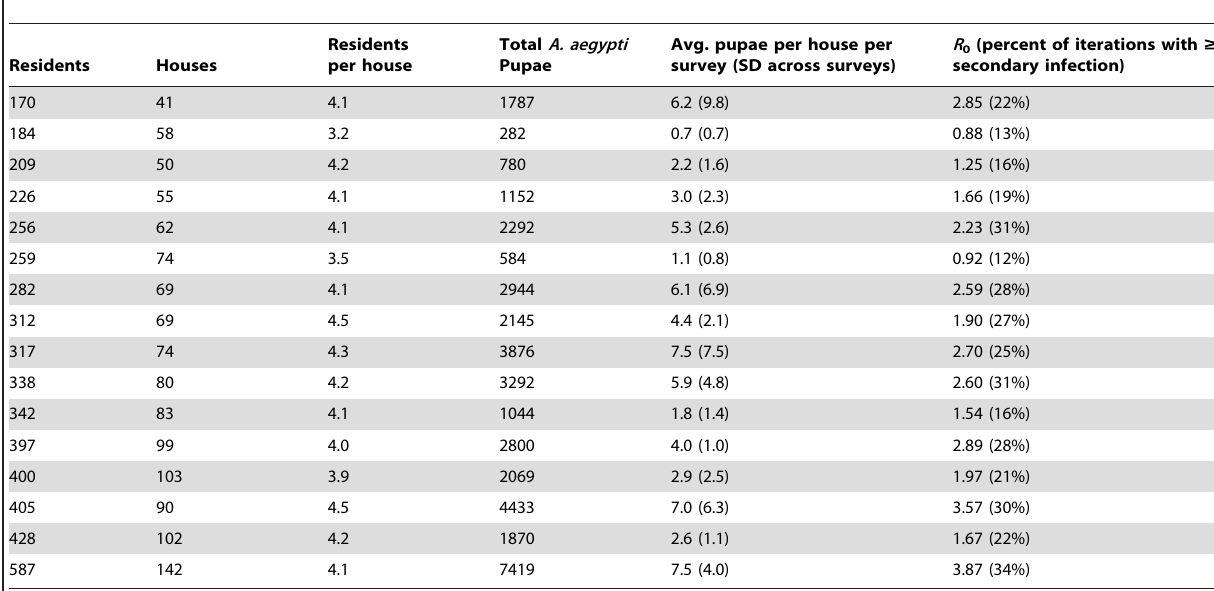
Table 1. Host density input data and simulated basic reproductive rate ( R 0 , number of secondary human infections averaged across 300 model iterations for each of 7 separate pupal surveys of dengue virus for each study patch.